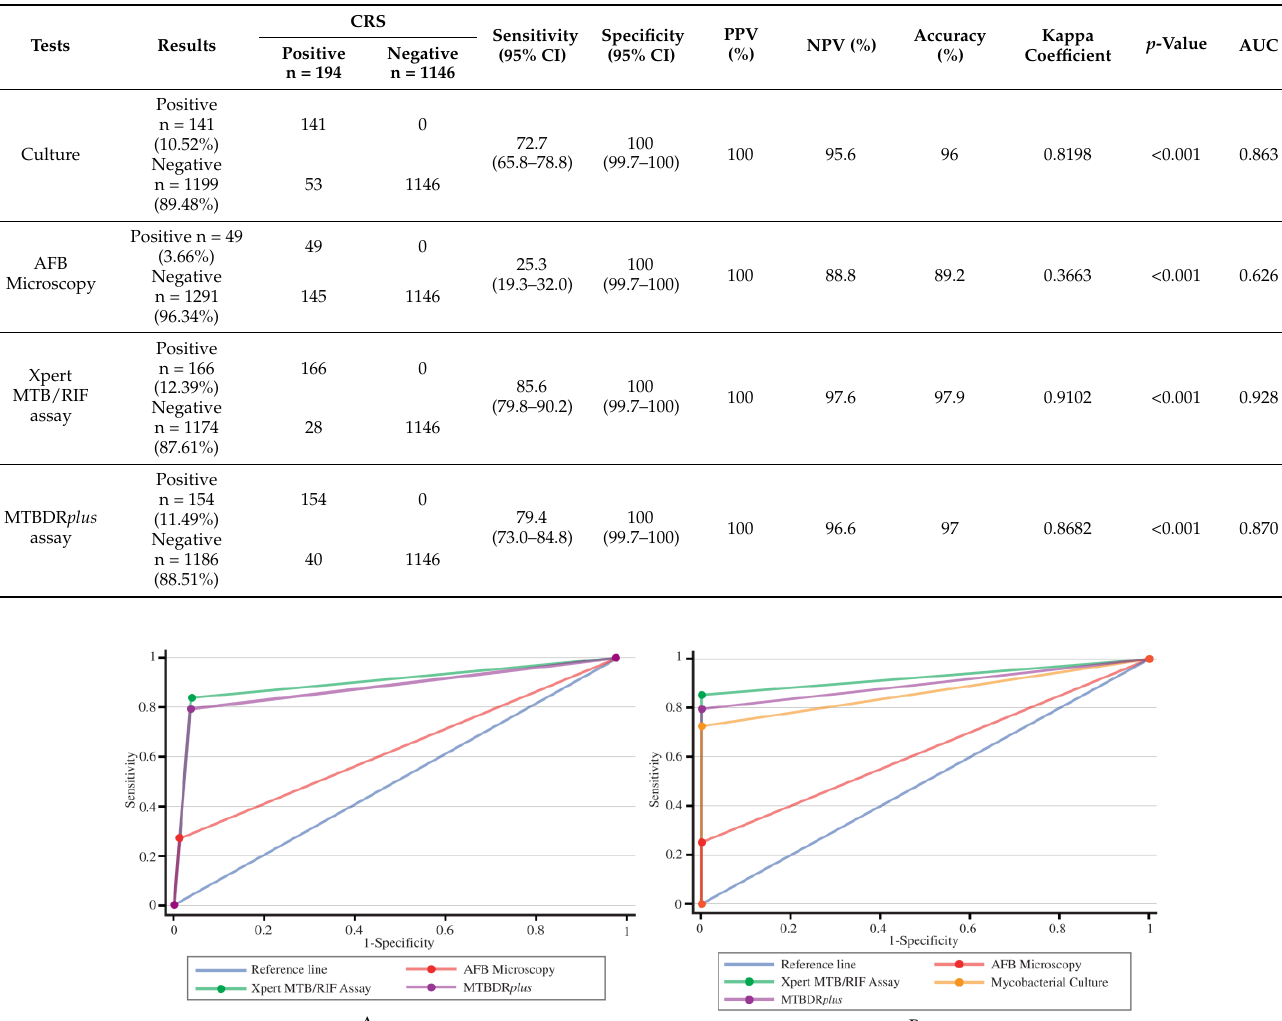
Table 2. Diagnostic performances of culture, AFB microscopy, Xpert MTB/RIF, and MTBDRplus for detection of EPTB cases compared to the composite reference standard.